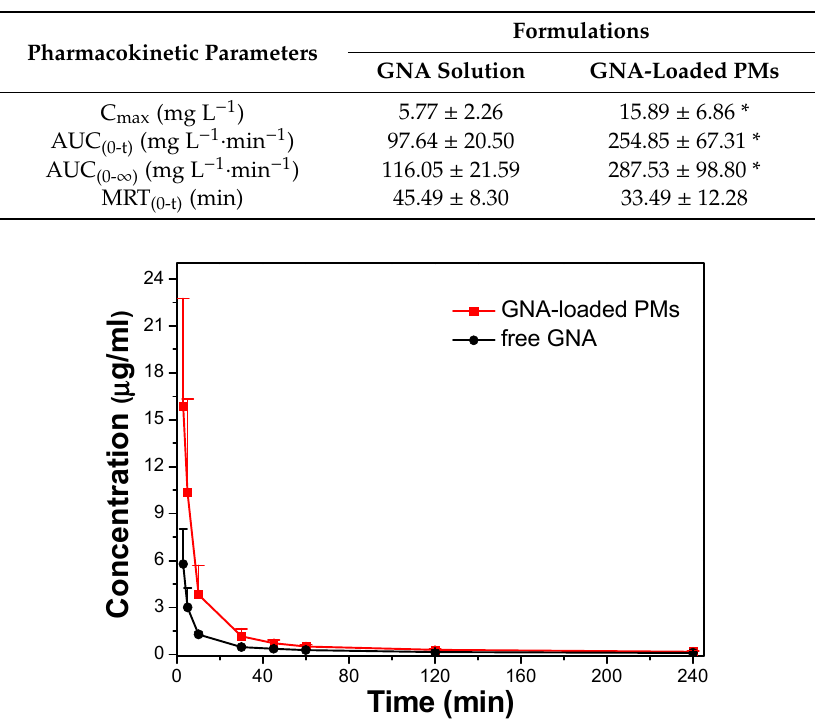
Table 3. Pharmacokinetic parameters after performance of GNA formulations for 1.5 mg / Kg dose as in rats ( n = 6).